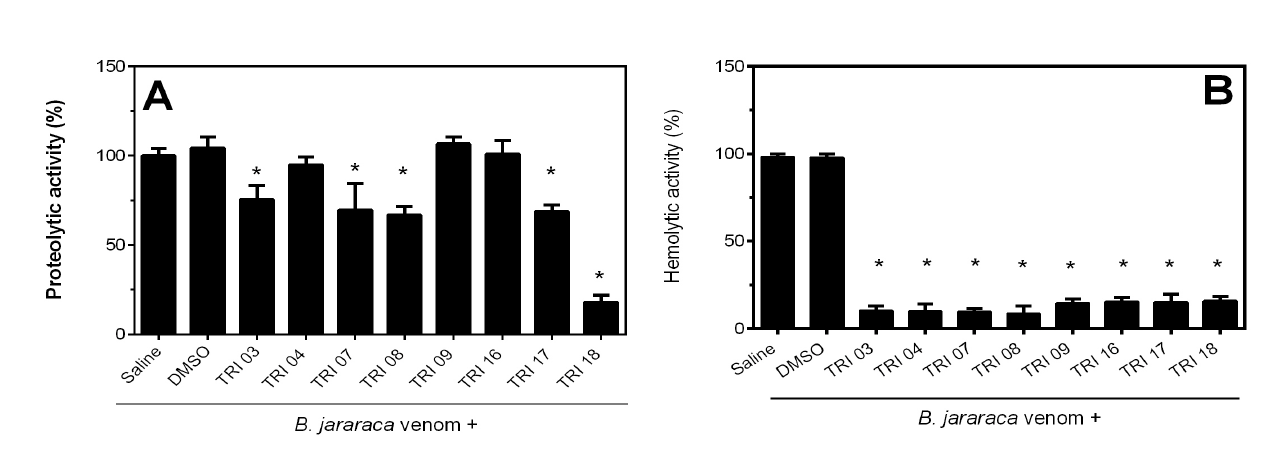
FIGURE 2 - Effect of the derivatives on proteolytic or hemolytic activity of B. jararaca